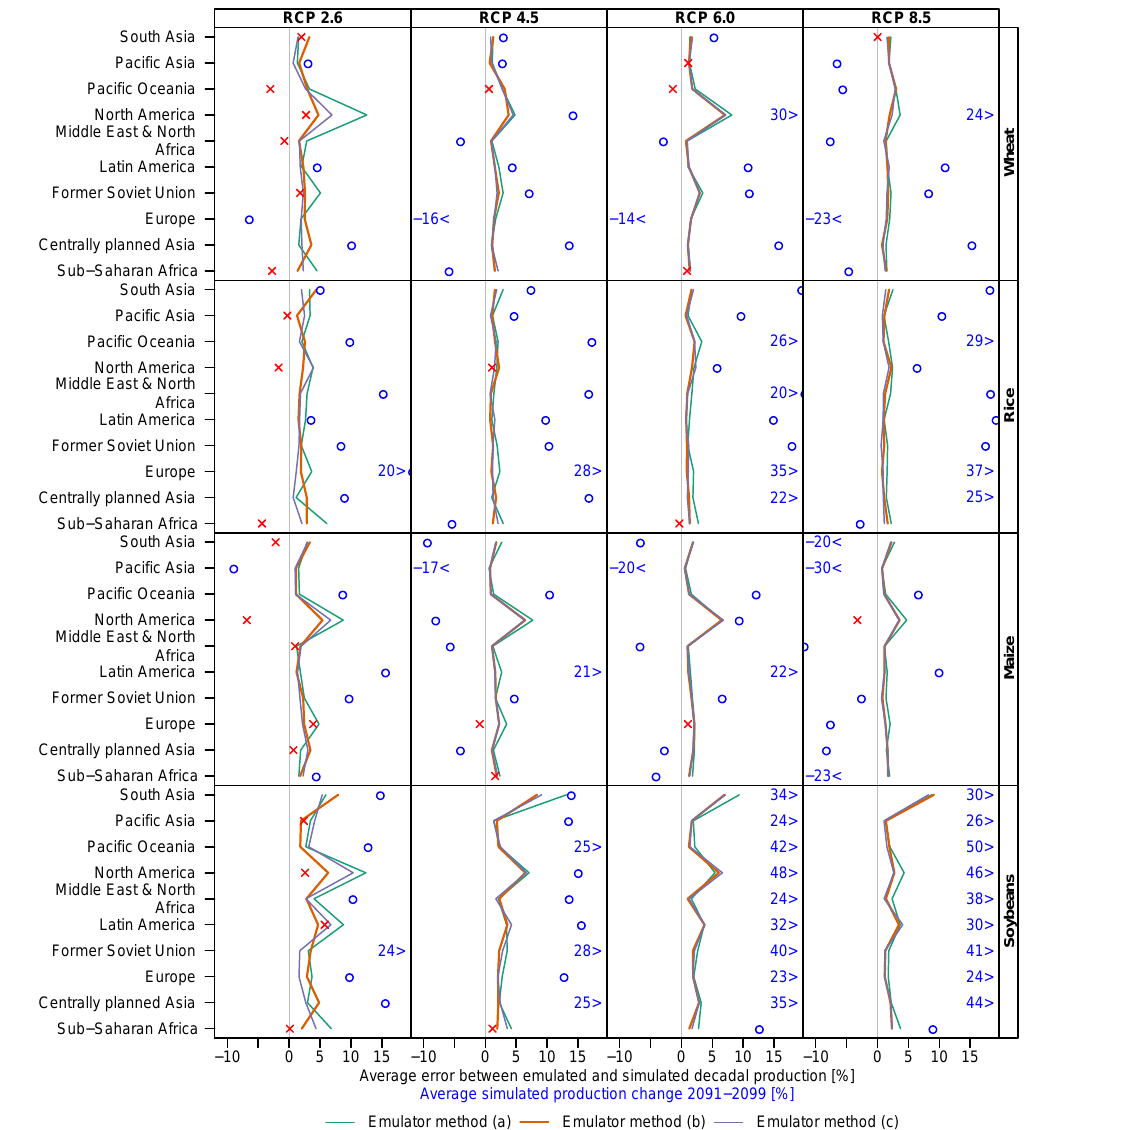
Figure 9. Root-mean-square difference (as a percentage) between emulated and simulated regional decadal production (yields multiplied by year-2000 growing areas, combined for irrigated and rain-fed crops) for LPJmL forced by HadGEM2-ES climate projections. The emulator was built using all available data and used to reproduce yield changes in all four RCPs. For comparison, point symbols illustrate the average simulated yield change for 2091–2099 (same horizontal axis), using red crosses or blue circles depending on whether the error between emulated and simulated production is larger or smaller than the simulated change. Simulated yield changes outside the plot range are indicated by a number in the plot margin. Analogous figures for the other crop models are available in the Supplement.